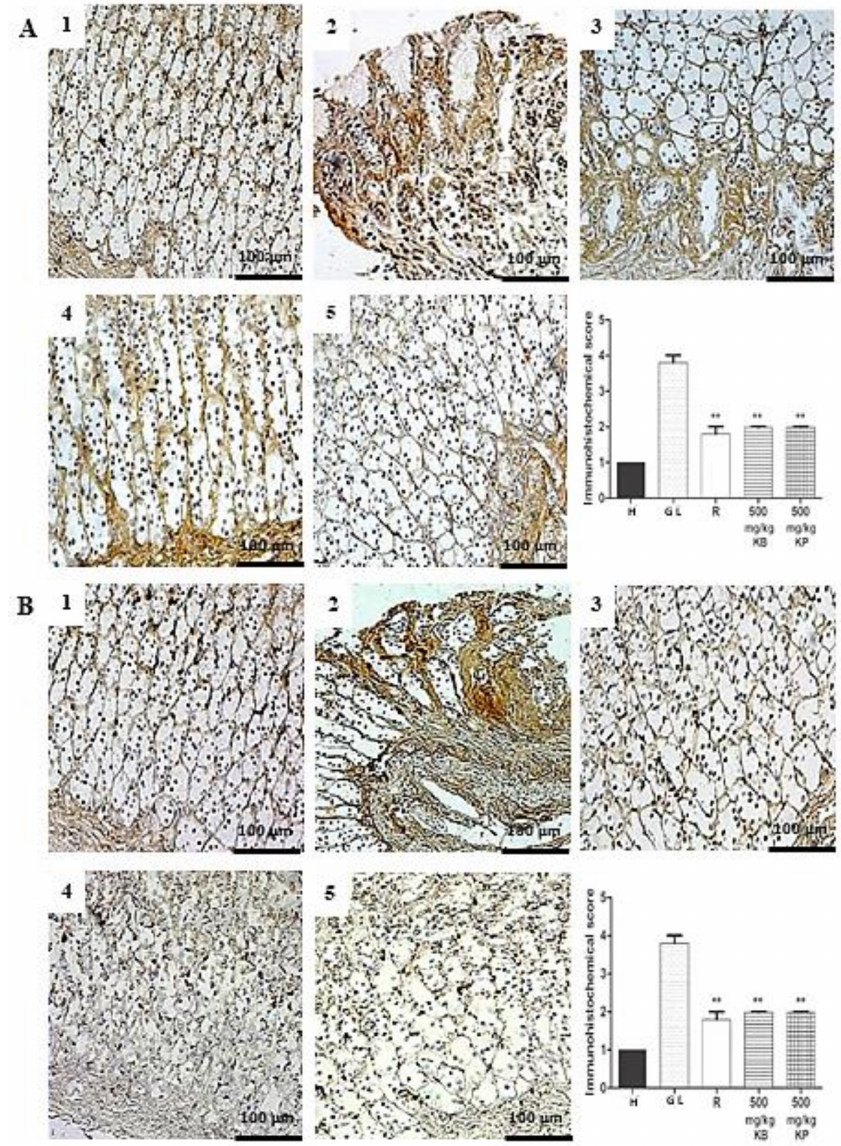
Figure 9. Immunohistochemical analysis of iNOS enzyme expression in the gastric mucosa in ethanol and indomethacin-induced gastric lesions in rats. Immunohistochemical analysis of iNOS enzyme expression in rat gastric tissue, showing the cut of the stomach in the longitudinal direction. ( A ) Ethanol-induced: (1) Healthy; (2) Gastric lesion control; (3) Ranitidine 50 mg/kg; (4) K. brasiliensis 500 mg/kg; (5) K. pinnata 500 mg/kg. ( B ) Indomethacin-induced: (1) Healthy; (2) Gastric lesion control; (3) Ranitidine 50 mg/kg; (4) K. brasiliensis 500 mg/kg; (5) K. pinnata 500 mg/kg. Data expressed as mean ± standard mean error, ( n = 5). Mann–Whitney used to calculate statistical significance, ** p < 0.01 vs. gastric lesion control. Healthy, H; Gastric lesion control, GL; Ranitidine, R. K. brasiliensis , KB; K. pinnata ,